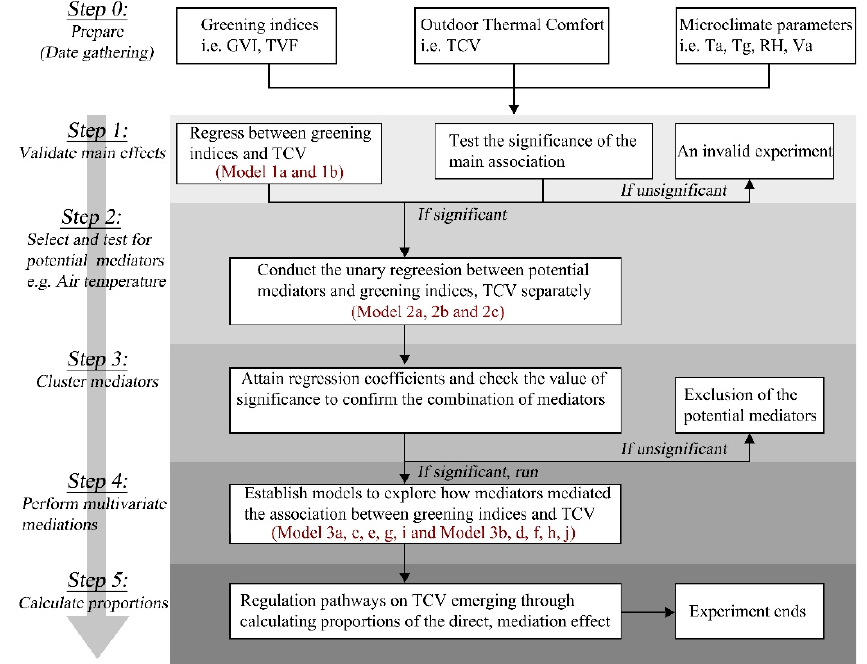
Figure 6. Analyses and workflow on the basis of the above definition.